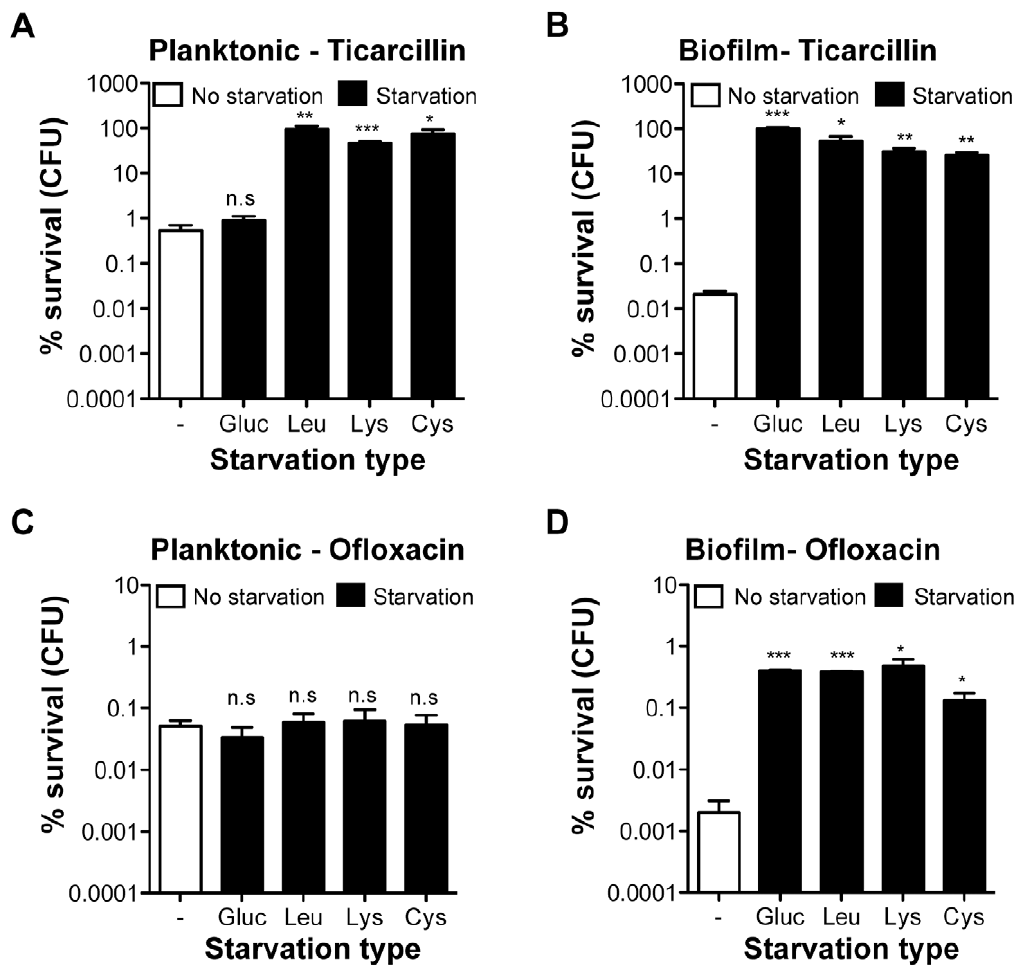
Figure 3. Antibiotic tolerance profile of starved planktonic and biofilm bacteria. Static cultures were grown for 24 h in M63B1 Gluc for wild- type prototroph TG1 (WT) and with the addition of 25 m g ml 2 1 of leucine, lysine, or cysteine for the corresponding auxotrophs. Planktonic bacteria from the 24-h static culture were removed from each well and therefore separated from the attached-biofilm cells. (A, C) Planktonic bacteria were then collected, spun, washed and treated in parallel with the biofilm bacteria (B, D) with ticarcillin (100 m g ml 2 1 , 100 6 MIC) or ofloxacin (5 m g ml 2 1 , 80 6 MIC) in the absence of glucose for WT prototroph TG1 (M63B1 medium) or amino acids for the different auxotrophic mutant strains (M63B1 Gluc medium) for 24 h. Survivor cells were quantified by viable cell counts. Percent survival represents the tolerant population after 24 h of treatment compared to the total number of CFU prior to addition of antibiotics. Equivalent CFU were present in all compared planktonic populations before antibiotic treatment. Data represented are means 6 SEM of at least three replicates. Asterisks indicate values significantly different from no starvation condition by the two-tailed unpaired t test: * P # 0.01, ** P # 0.001, *** P # 0.0001 and n.s. (not significant). The genotypes of the three amino acid auxotrophic mutants constructed in the WT prototroph TG1 genetic background are described in Table S1 or as follows: leucine (Leu: D leuC ::GB), lysine (Lys; D lysA ::KmFRT), and cysteine (Cys; D cysD ::KmFRT).